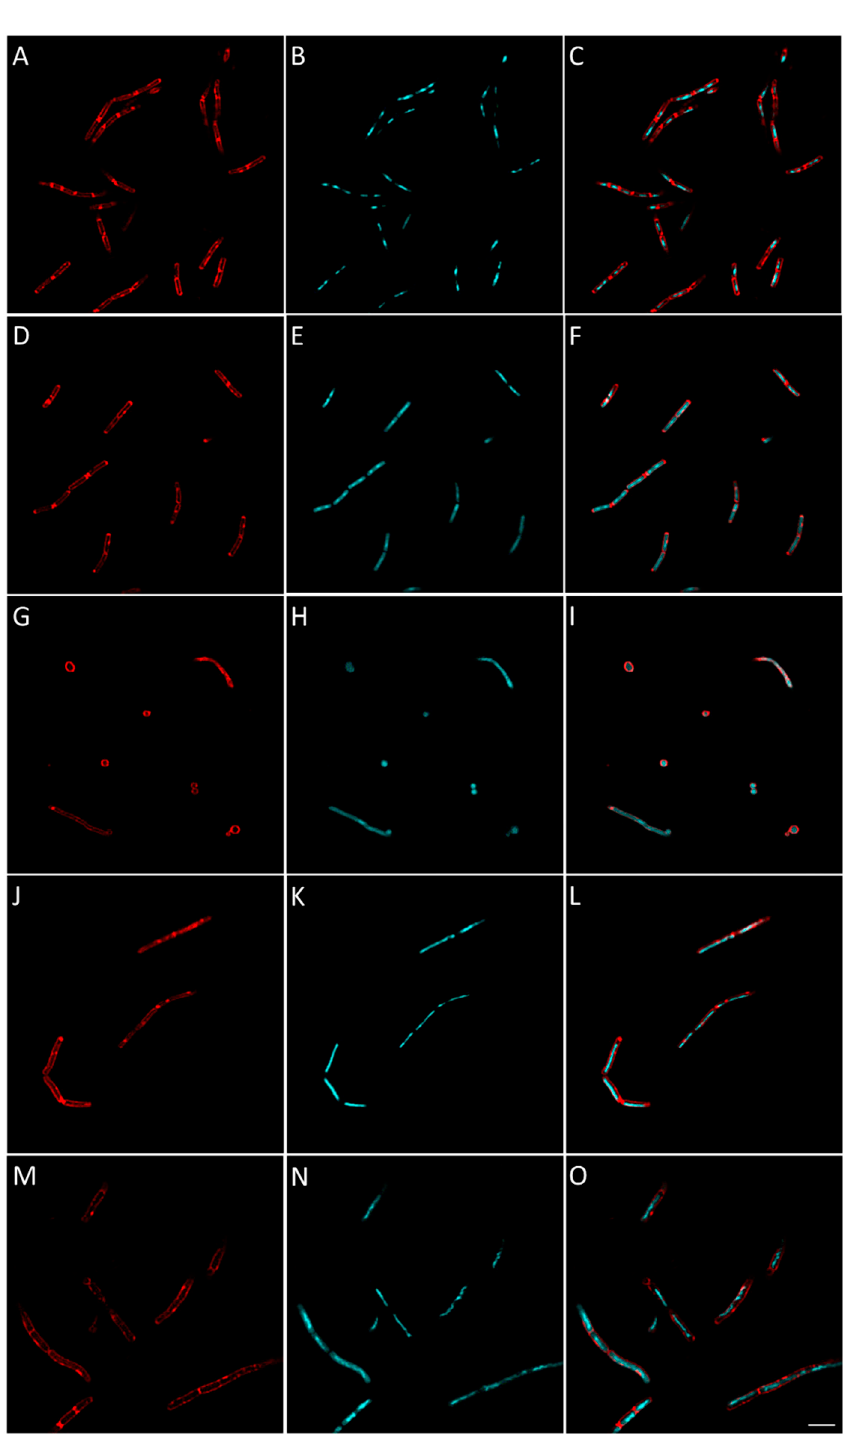
Figure 7. Morphological bacterial changes caused by conventional antibiotics in B. subtilis . Morphological changes of B. subtilis caused by conventional antibiotics were studied as explained in the Materials and Methods section. B. subtilis was incubated for 2 h at 37 °C in aerobic conditions with 4 × MIC of conventional antibiotics with known bacterial target. Control ( A – C ) was bacteria with no antibiotics added. Antibiotics used were: amoxicillin (( D – F ), inhibiting cell wall synthesis), gemifloxacin (( G – I ), inhibiting DNA synthesis), fifampicin (( J – L ), inhibiting RNA synthesis) and tetracycline (( M – O ), inhibiting protein synthesis). Images shown are representative of overall observed effects and correspond to bacterial membrane stained with FM4-64FX (red signal) ( A , D , G , J , M ), bacterial DNA stained with DAPI ( B , E , H , K , N ) and merged membrane and DNA signals ( C , F , I , L , M , O ). The white scale bar on the bottom right corner corresponds to 4 µm.